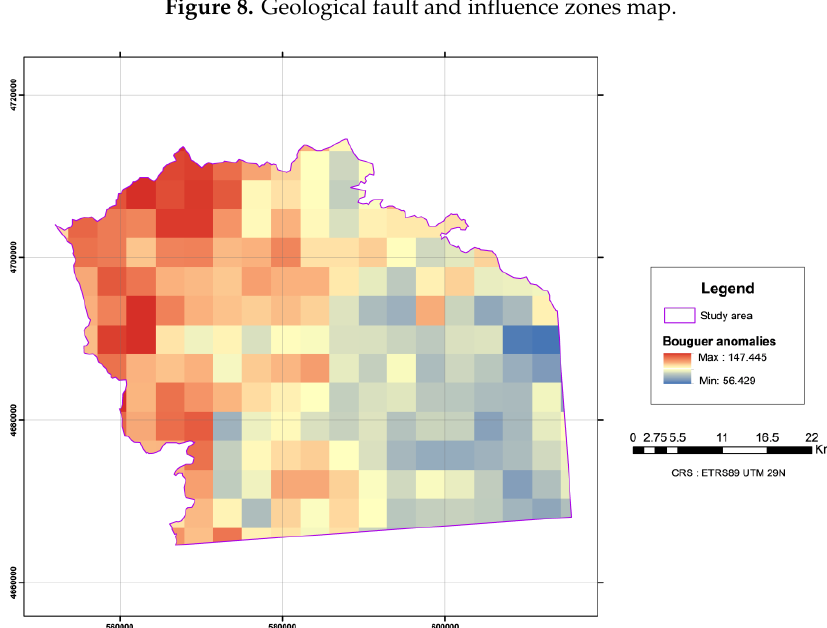
Figure 9. Bouguer gravimetric anomaly map.